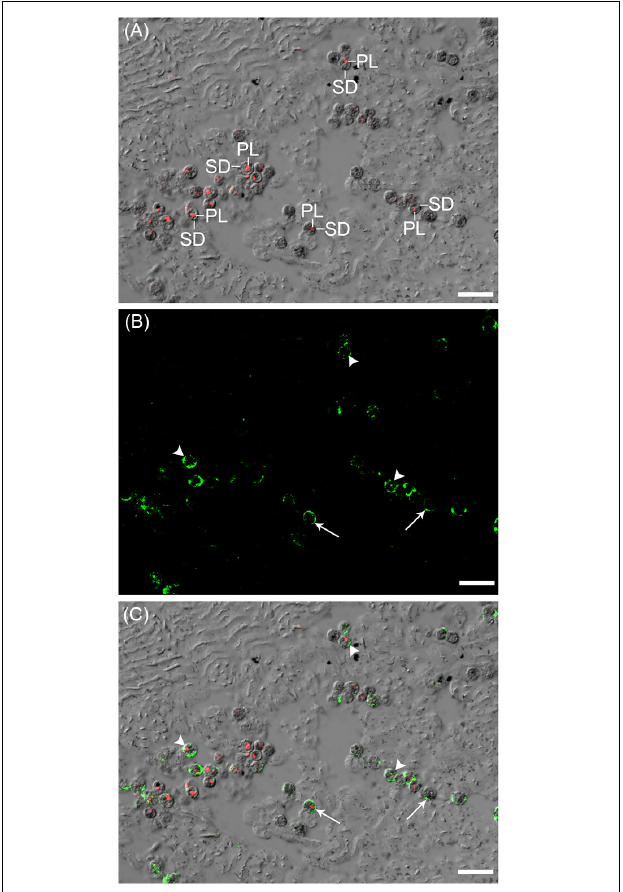
FIGURE 3 | Immunolabeling of zooxanthellae-nitrate transporter 2 (Zoox-NRT2), which comprised NRT2 of Symbiodinium, Cladocopium and Durusdinium , in the outer mantle of Tridacna squamosa . (A) The differential interference contrast (DIC) image is overlaid with the red channel showing autofluorescence of the plastids (PL) of symbiotic dinoflagellates (SD). (B) The green channel showing green immunofluorescence of Zoox-NRT2 labeled with the anti-Zoox-NRT2 antibody. (C) The DIC image overlaid with the red channel and green channel. Arrows indicate Zoox-NRT2 immunolabeling (green) of the plasma membrane of SD. Arrowheads indicate Zoox-NRT2 immunolabeling (green) of intracellular vesicles in SD. Scale bar: 20 µ m. Replicable results were obtained from three individuals of T. squamosa .